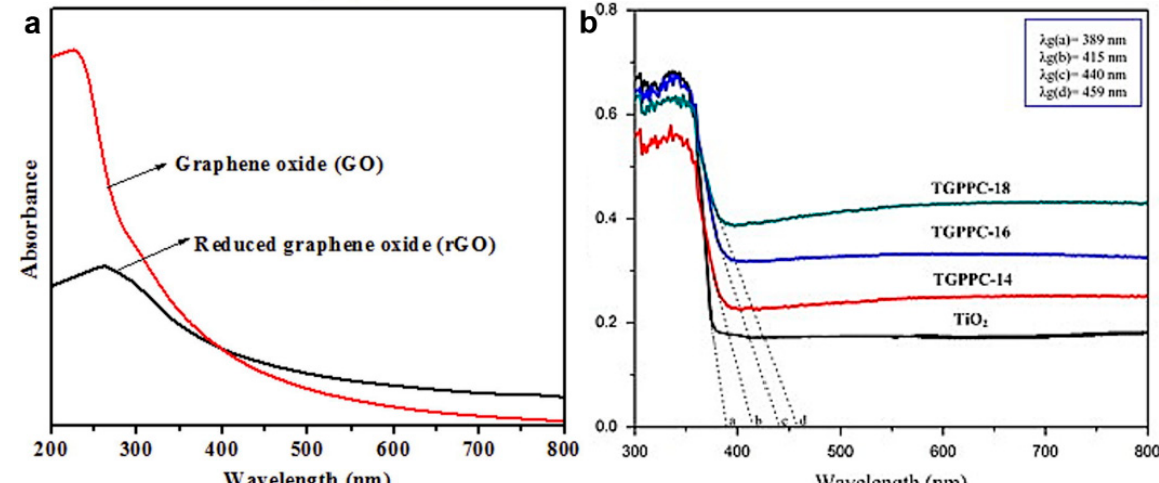
Figure 10. Comparison of UV-Visible spectra of ( a ) aqueous solutions of GO and RGO [176] (Reprinted with permission from [176] Copyright 2017 Elsevier Ltd.) and ( b ) mixed composites with different content of graphene [175] (Reprinted with permission from [175] Copyright 2015 Elsevier Ltd.).